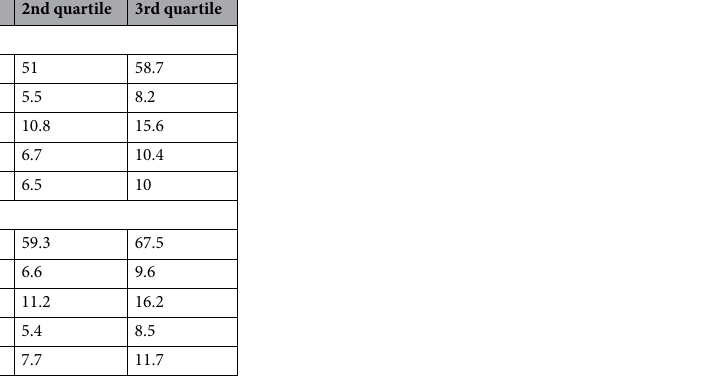
Table 3. Cut-off values for mean high-density lipoprotein cholesterol levels in men and women. ARV average real variability, CV coefficient of variation, SD standard deviation, VIM variability independent of the